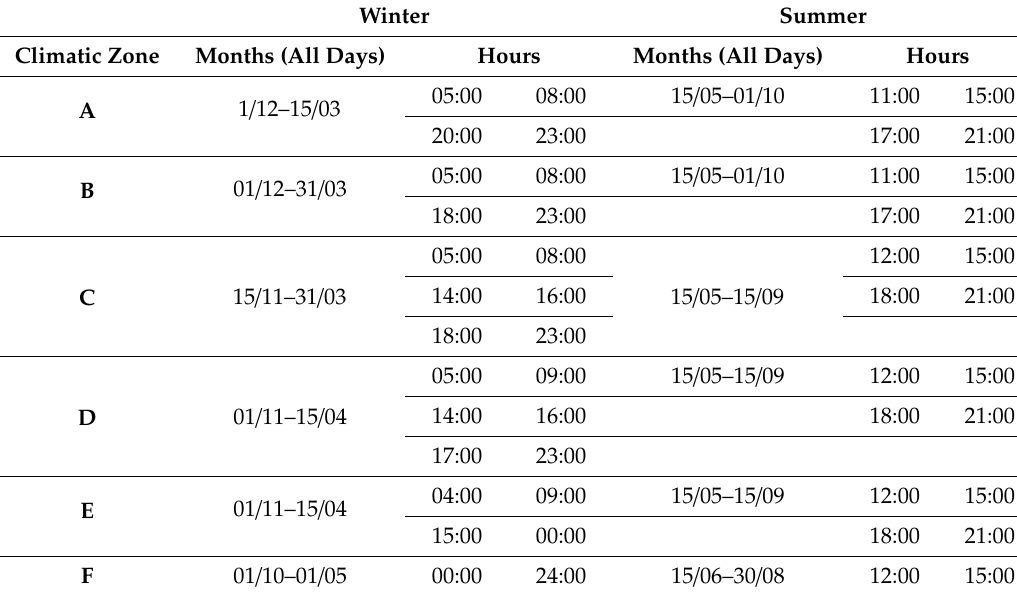
Table 2. Operational period for the heating and cooling